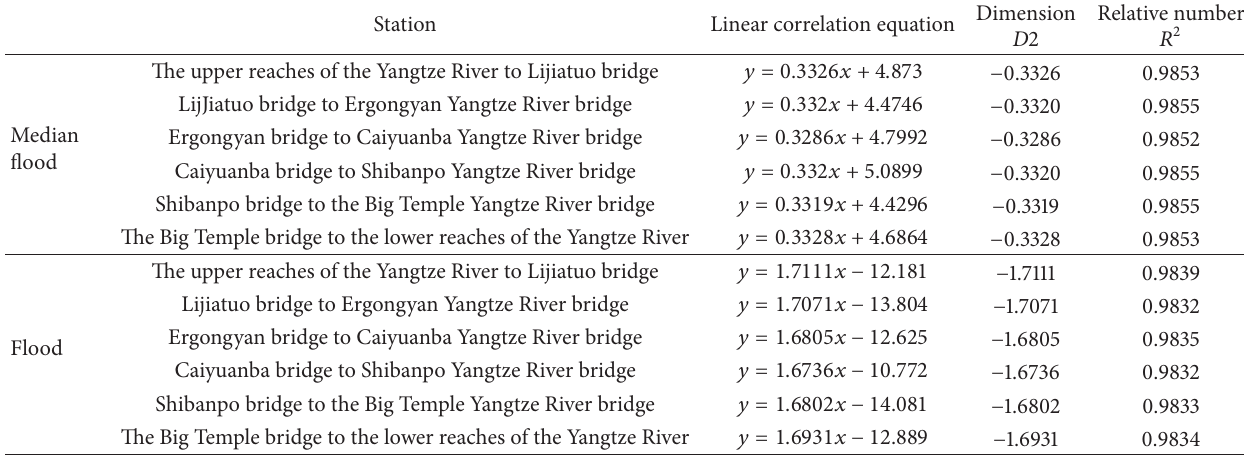
Table 6: The result of second-order accumulated variable-dimensional fractal sequence of Chongqing city of Yangtze River right bank. Station